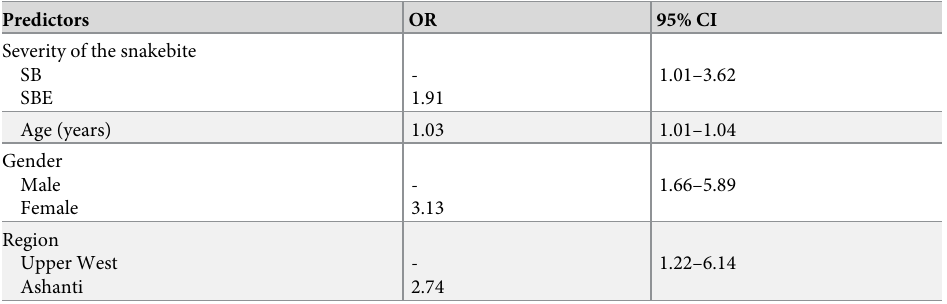
Table 3. Results of the dichotomous logistic regression analysis on the variables best predicting disabilities in snakebite